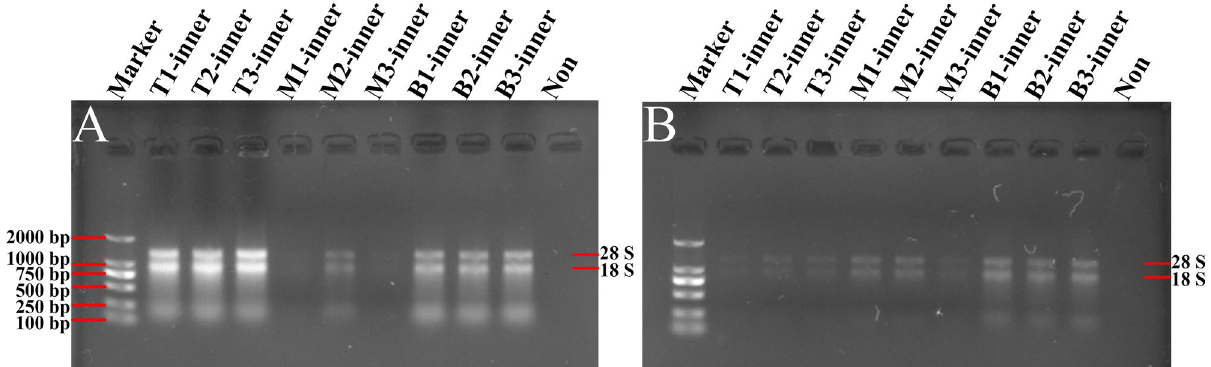
Figure 6. Gel images of total RNA from inner scales of Lilium lancifolium Thunb. and Lilium brownii var. viridulum Baker isolated using TRIzol method. The RNA samples extracted by TRIzol method were separated and analyzed in 1% agarose gels, respectively. Then the gels were visualized and exposed by Gel Imager System in different fields, and pictures were taken, respectively. The order of samples of each gel lane is as follows: ( A ) Lane 1: DL2000 DNA marker; Lanes 2–4 are RNA isolated from top scales of Lilium lancifolium Thunb.; Lanes 5–7 are RNA isolated from middle scales of Lilium lancifolium Thunb.; Lanes 8–10 are RNA isolated from basal scales of Lilium lancifolium Thunb.; Lane 11: Loading buffer solution without RNA to serve as a control; ( B ) Lane 1: DL2000 DNA marker; Lanes 2–4 are RNA isolated from top scales of Lilium brownii var. viridulum Baker; Lanes 5–7 are RNA isolated from middle scales of Lilium brownii var. viridulum Baker; Lanes 8–10 are RNA isolated from basal scales of Lilium brownii var. viridulum Baker; Lane 11: Loading buffer solution without RNA to serve as a control . 28S and 18S represent the location of 28S and 18S rRNA method, the highest RNA concentration was obtained from root, stem, leaf (Table 1) and different parts of scales (Tables 2, 3) in Lilium , with the A260/A280 ratios ranging from 1.97 to 2.27. Although the A260/A230 ratios for different tissues were still low, the 28S and 18S rRNA bands could be clearly observed, confirming the integrity of the RNA samples isolated by the modified TRIzol method (Figs. 1, 2, 3, 4). These results were further certi- fied by comparing the modified TRIzol method with the TRIzol method in other edible bulb samples ( Lilium lancifolium Thunb. and Lilium brownii var. viridulum Baker) (Figs. 5, 6). The relatively lower RNA concentrations in these edible bulbs in comparison with Lanzhou lily may be caused by the long-term storage and transporta- tion, while bulbs of Lanzhou lily were collected locally. In addition, for different scales of Lilium , it was easier to obtain high yield and quality total RNA from the basal part of the scales (Tables 2, 3). This might because that